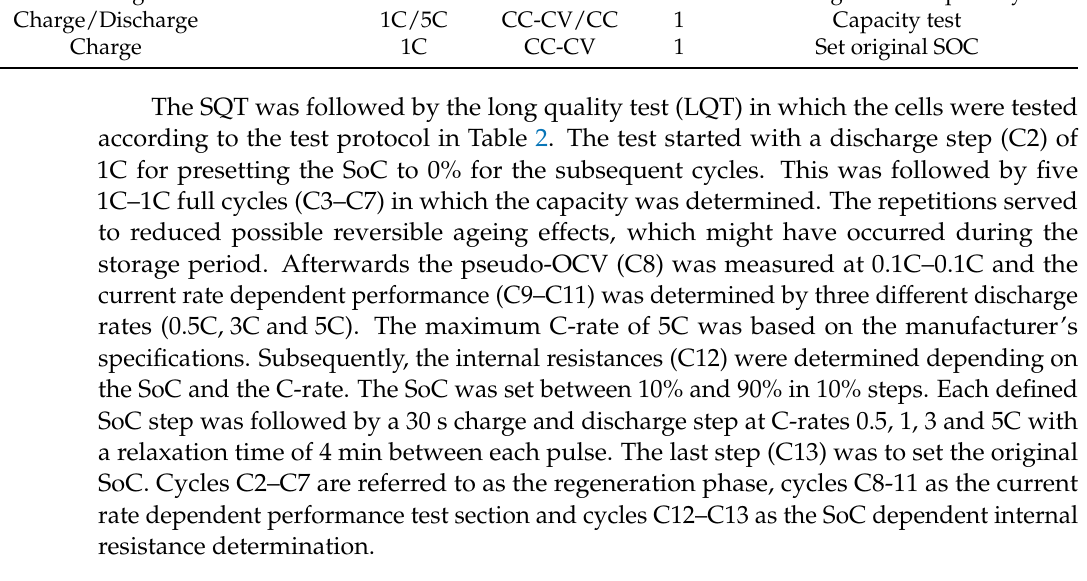
Table 2. The testing protocol of the long quality